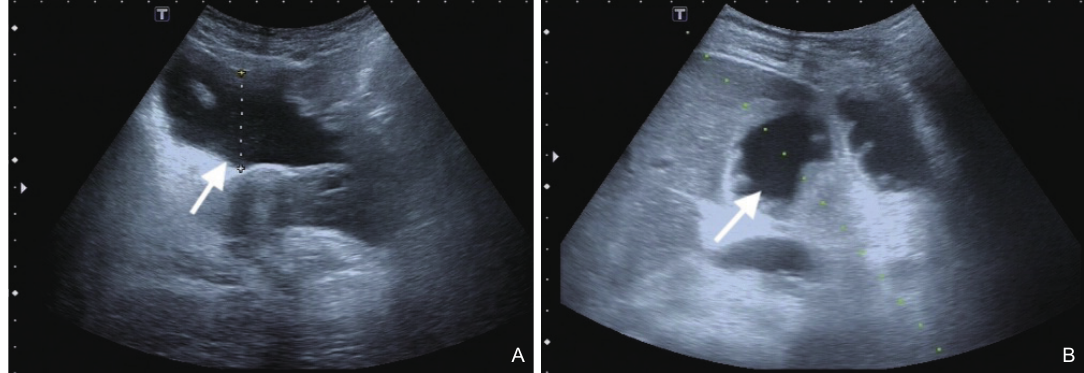
Figure 2 (A) A small amounts of ascites (,white arrow); (B) Dliated intestines (white